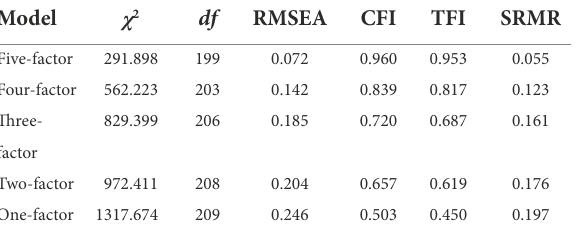
TABLE 2 Alternative model test results for the study